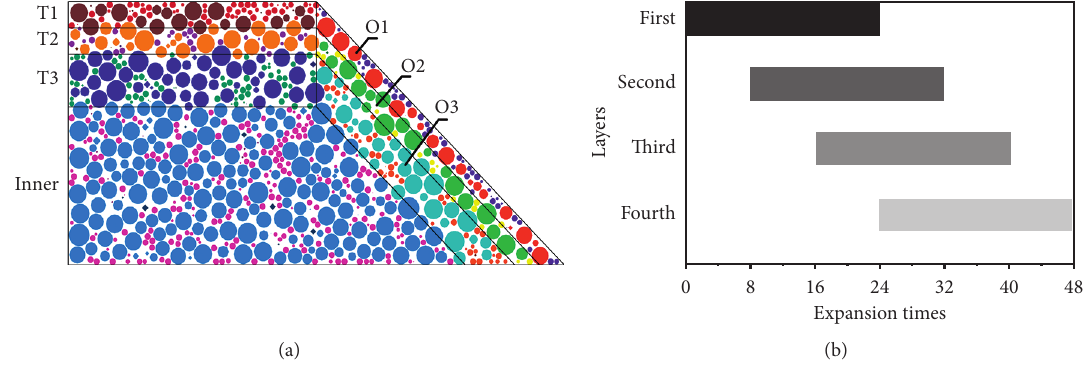
Figure 6: Layered slopes and FH. (a) Layered slope. (b) Layered FH.